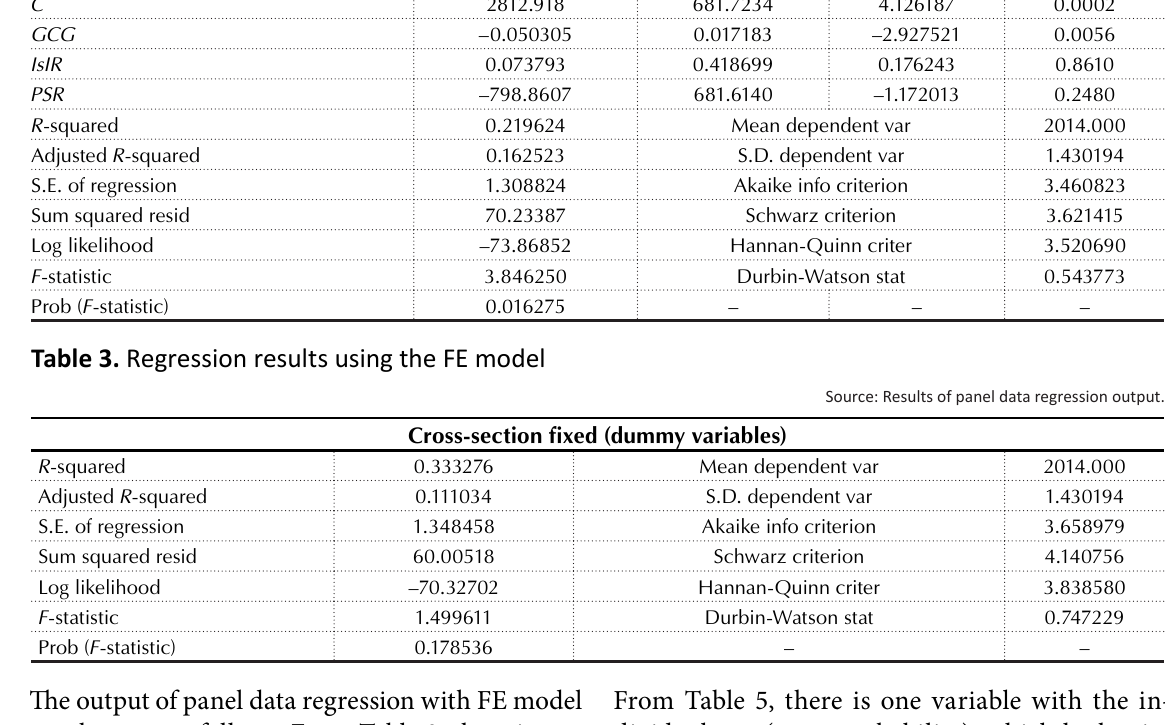
Source: Results of panel data regression output.